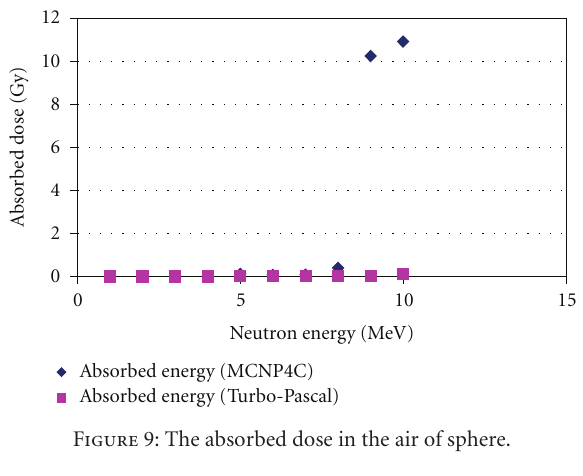
Figure 9: The absorbed dose in the air of sphere.